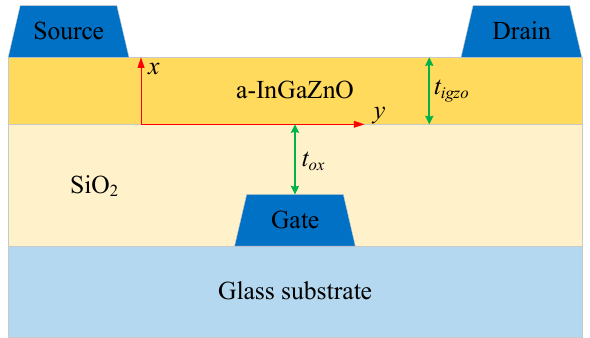
Figure 1. A cross-section schematic of bottom-gate a-InGaZnO TFTs. Generally, the free charge density and the complete density of trap states including exponential tail states and deep states in the a-InGaZnO thin film directly affect the electrostatic characteristics of a-InGaZnO TFTs. In the case of non-degenerate, considering the gradual channel approximation and ignoring percolation conduction mechanism [34], a one-dimensional Poisson equation is listed